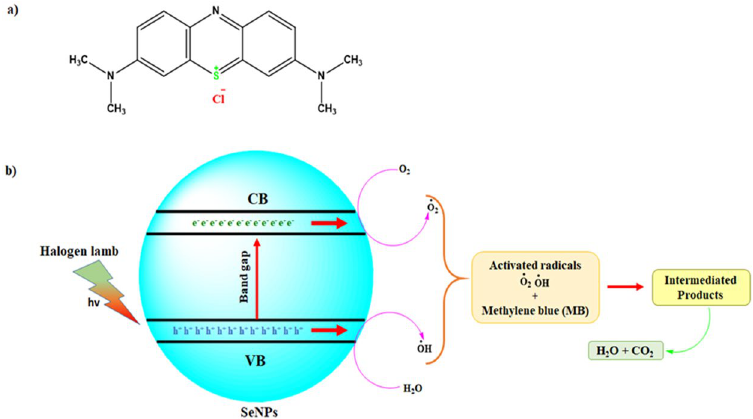
Figure 15. ( a ) Structure of methylene blue ( b ) scheme of the photocatalytic mechanism of the rapid synthesized SeNPs under halogen light